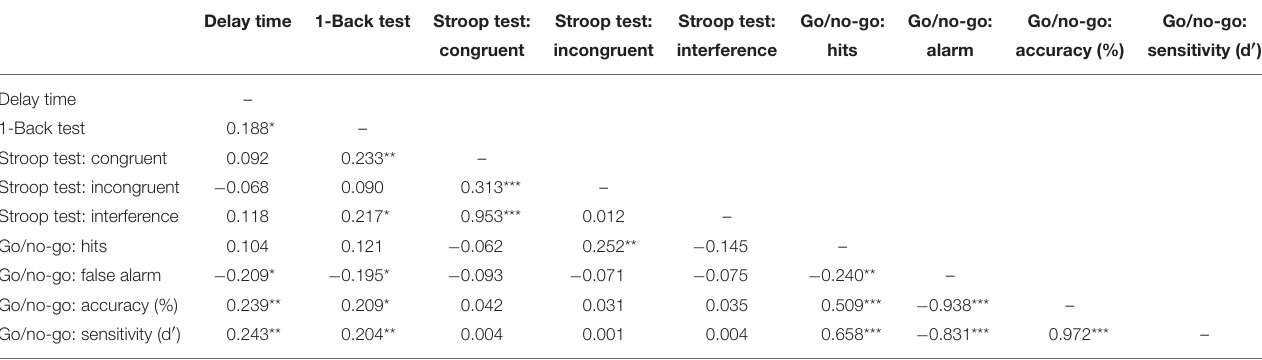
TABLE 3 | Partial correlation among task measures and delay time controlling for age in